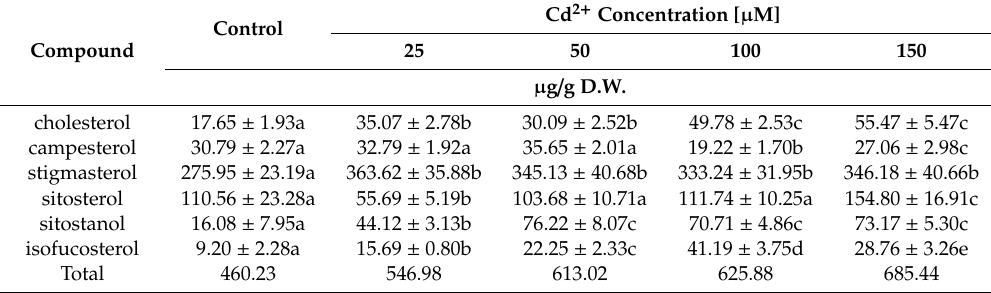
Table 2. The content of sterols in line CC16 hairy root tissue after treatment with Cd 2 + ions.